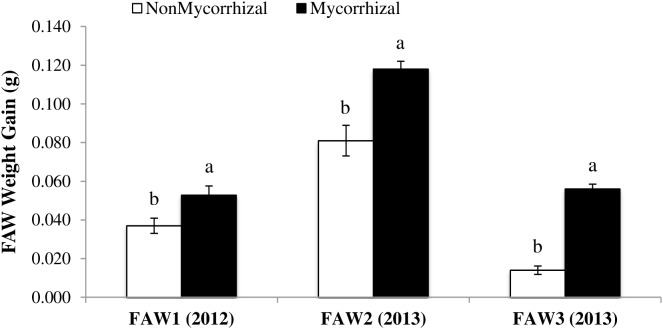
Weight gain (g ± SE) of Spodoptera frugiperda larvae fed on rice leaves from nonmycorrhizal (NM) and mycorrhizal (M) plants in lab studies during 2012 and 2013. Feeding assays were performed for 4, 7, and 10 days with larvae of 4 to 5 days old. NonMycorrhizal: rice seeds + sterilized AMF, Mycorrhizal: rice seeds + live AMF. Bars and lower case letters at the column head indicate that means differ significantly (LSD, P ≤ 0.05).